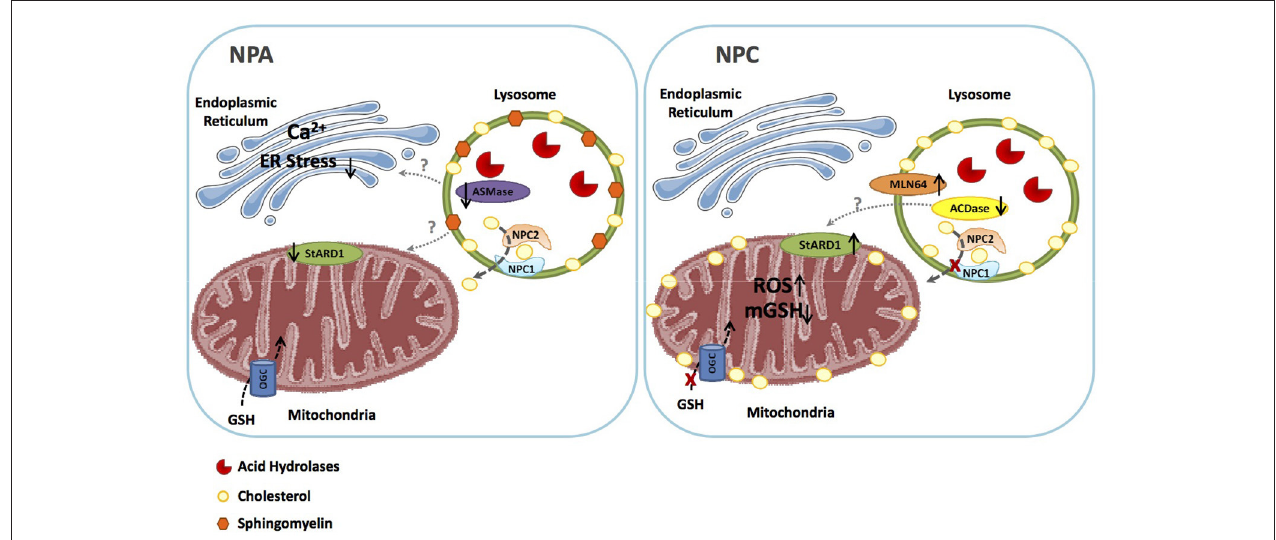
FIGURE 2 | Similarities and differences between NPA and NPC. NPA disease due to ASMase deficiency is characterized by the primary accumulation of shingomyelin in lysosomes, which secondarily lead to the sequestration of cholesterol in these organelles. As ASMase triggers ER stress, the ablation of ASMase impairs ER stress signaling, and consequently the expression of StARD1. Thus, in NPA the bulk of cholesterol accumulation is restricted to lysosomes but not mitochondria, which allows the transport of GSH into the mitochondrial matrix via the 2-oxoglutarate carrier (OGC). In NPC, however, although primarily accumulates in lysosomes, mitochondrial cholesterol transporting polypeptides, such as MLN64 contribute to mitochondrial cholesterol loading. Moreover, besides MLN64, StARD1 is also induced in NPC cells by a poorly understood mechanism independent of ER stress, with the potential involvement of the downregulaton of acid ceramidase, which has been shown to repress StARD1 expression. The subsequent mitochondrial cholesterol accumulation then impairs the transport of GSH into mitochondria, resulting in mitochondrial GSH depletion and subsequent oxidative stress. These findings constitue the basis for the potential beneficial effects of mGSH replenishment by GSH ethyl ester in